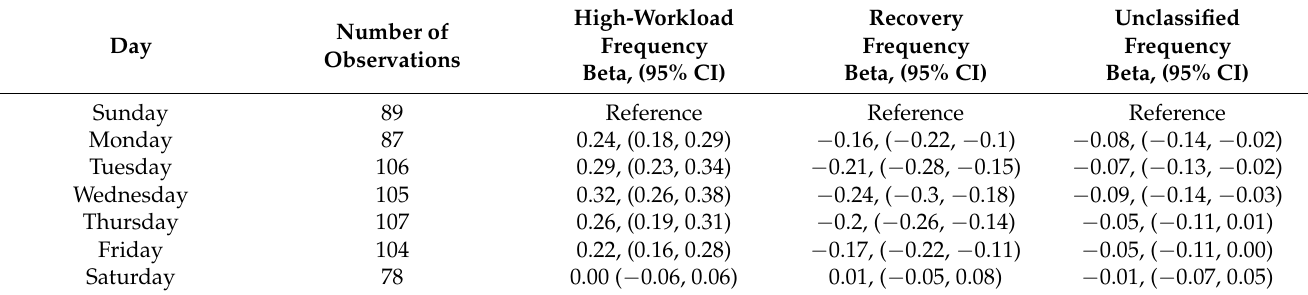
Table 6. Day-of-week differences in activity frequencies. Values in parentheses represent 95% confidence